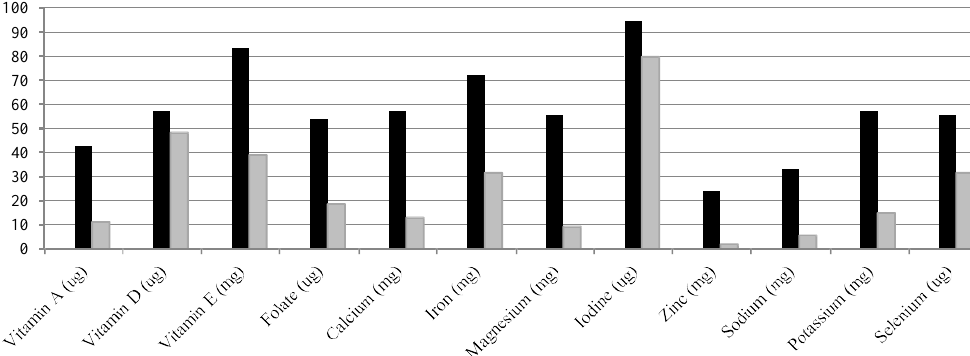
Figure 2. Percentage of celiac women who do not achieve dietary reference intake of the vitamins and minerals proposed by the Federation of Spanish Societies of Nutrition and Dietetics (FESNAD). ■ Completely fulfilled dietary reference intakes; ■ With dietary reference intakes below 67%.